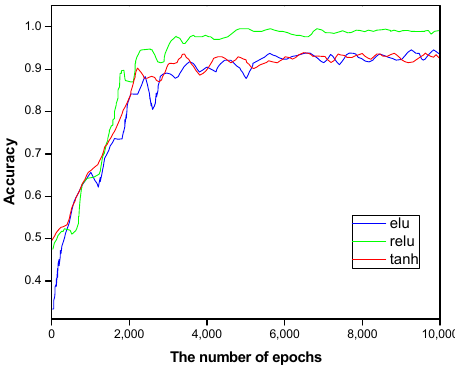
Figure 7. The accuracy curve of different activation functions.